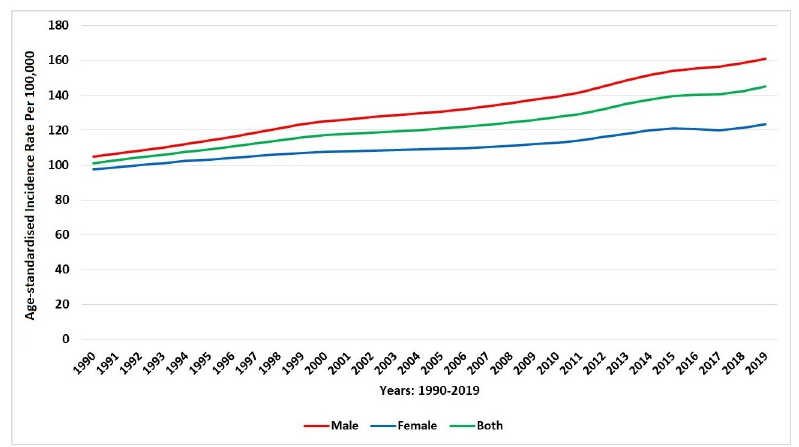
Fig 3. Trends in the age-standardised incidence rate of COPD during 1990–2019 in Saudi Arabia, stratified by gender.